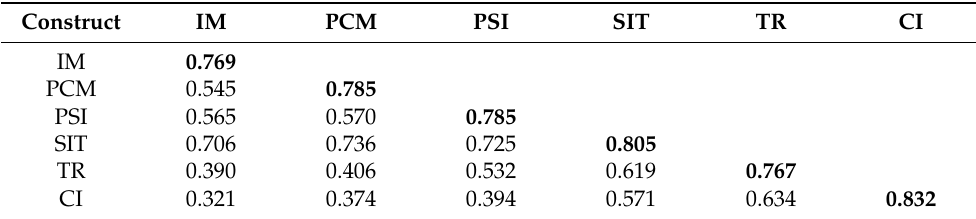
Table 4. Correlation matrix.